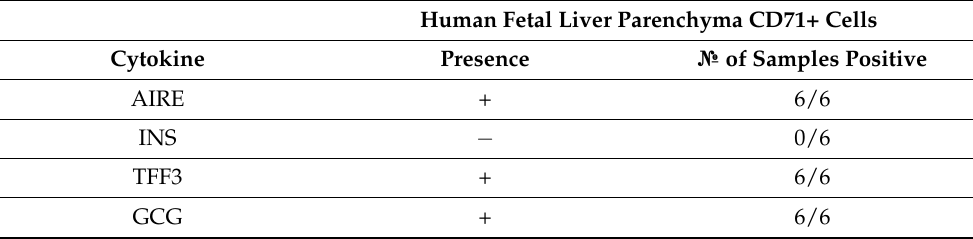
Table 2. Presence of AIRE and TSAs gene expression in Human Fetal Liver Parenchyma CD71+ cells. Human Fetal Liver Parenchyma CD71+ Cells Cytokine Presence № of Samples Positive AIRE + 6/6 INS